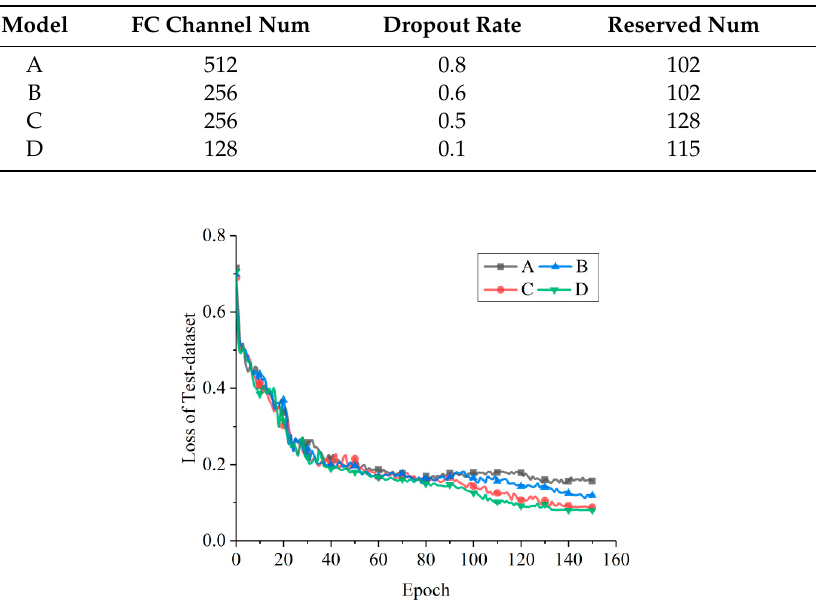
Table 5. Variable combination of the channel number and dropout rate.